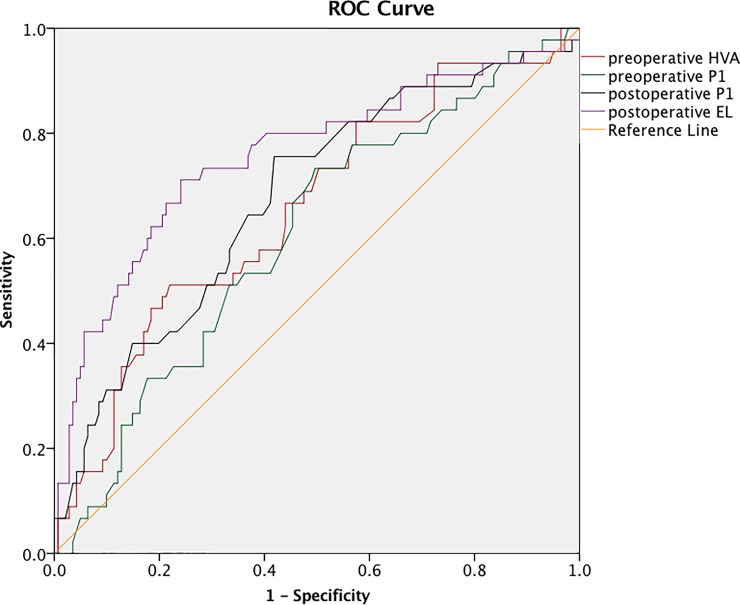
ROC curves.The binary logistic regression analysis was performed to determine the risk factors for recurrence. Significant associations with hallux valgus recurrence were found for preoperative HVA, postoperative P1(OR = 8.67, p = 0.03) and postoperative EL(OR = 6.79, p = 0.001). However, the preoperative P1 (OR = 0.37, p = 0.3) and preoperative EL (OR = 0.8, p = 0.57) did not show significant associations with hallux valgus recurrence. (Table 3).